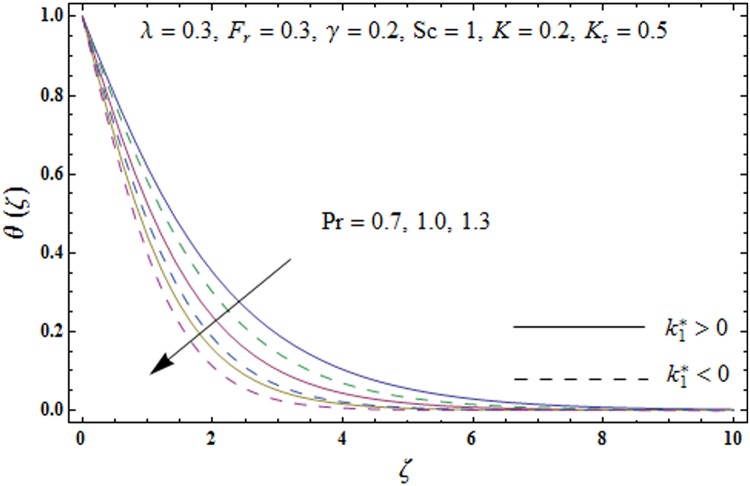
Plots of temperature field θ(ζ) for Prandtl number Pr.